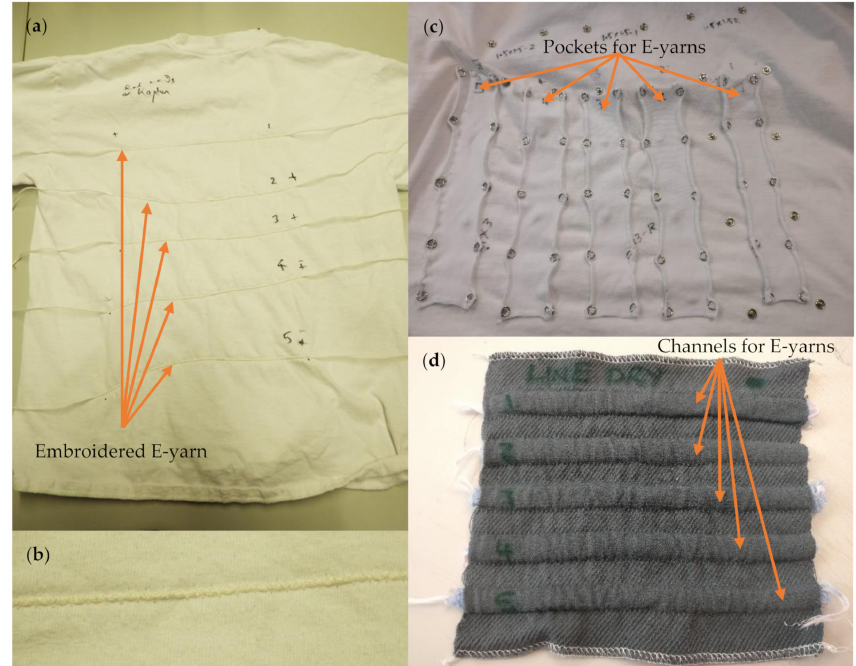
Figure 2. Textiles designed to hold E-yarns during wash tests: ( a ) A T-shirt with E-yarns embroidered onto the surface. ( b ) Image of an embroidered E-yarn. ( c ) Pockets on the surface of a T-shirt designed to hold E-yarns. ( d ) A woven textile with channels into which acoustic sensing E-yarns were